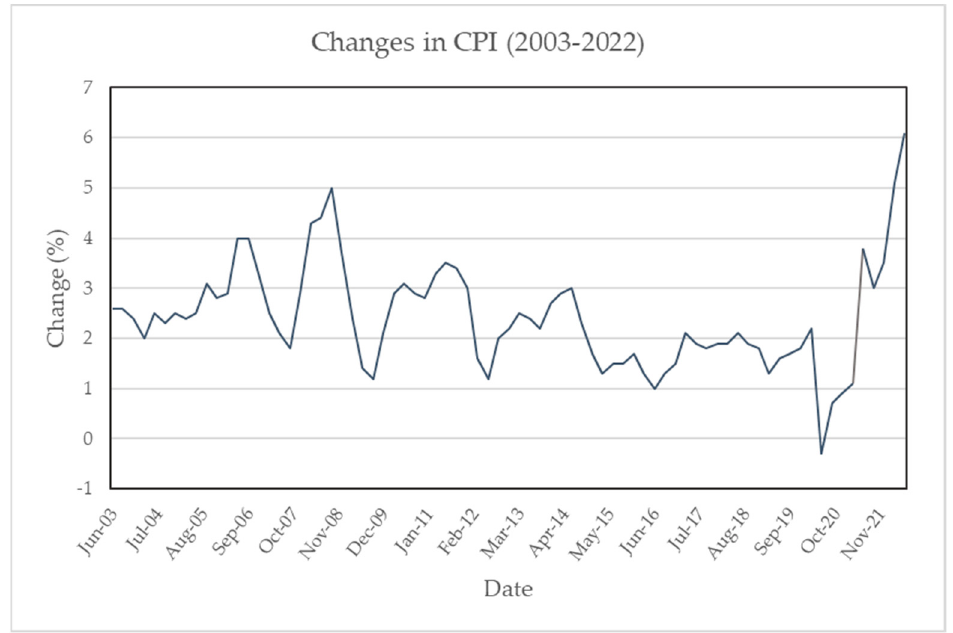
Figure 4. Changes in CPI (Quarterly, 2003–2022). (Data source: https://www.abs.gov.au; accessed on 3 September 2022).